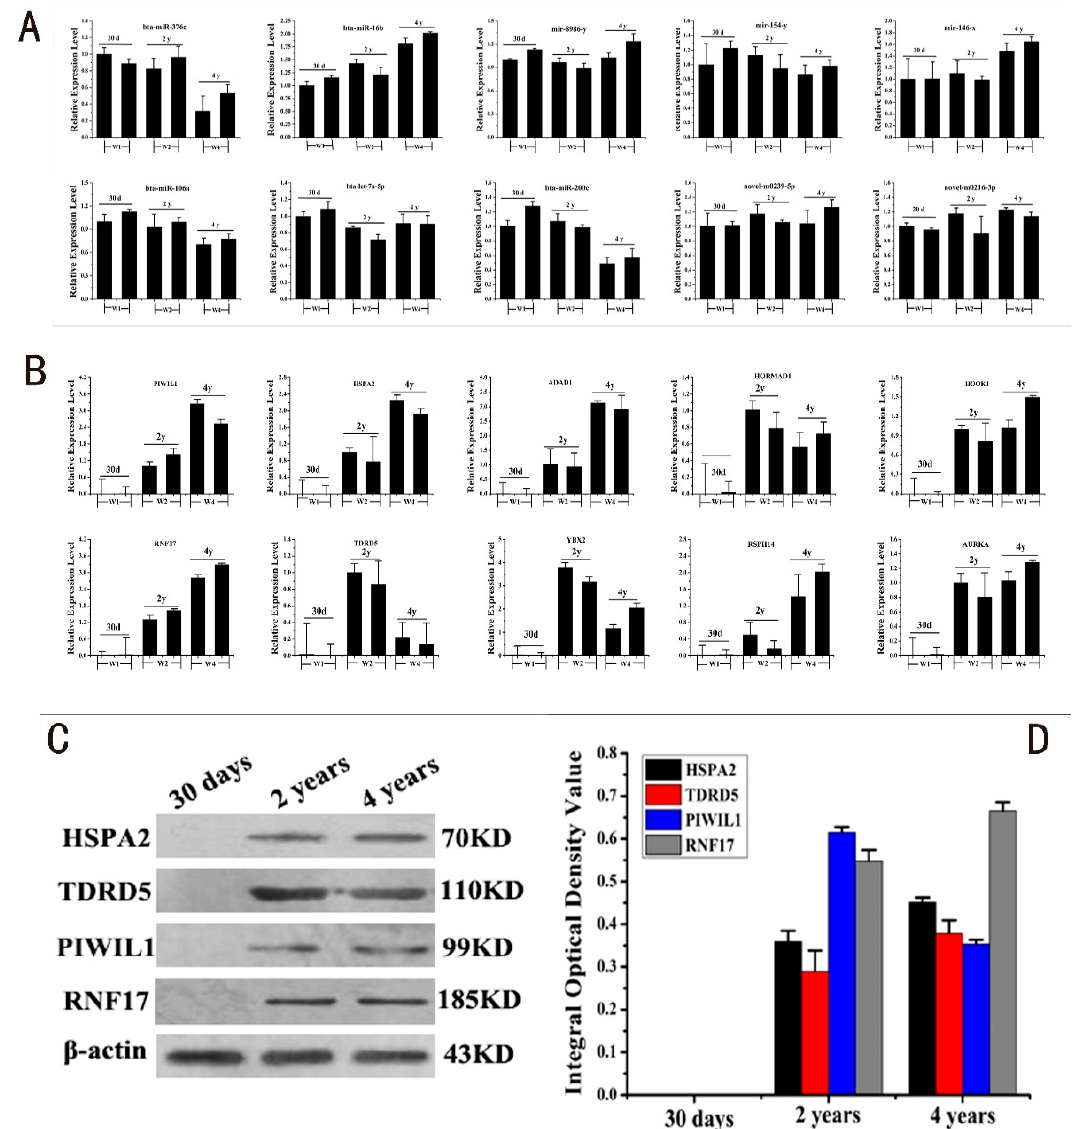
Figure 4. RT-PCR and Western blot assays for validating DERs and DEGs. ( A ) Stem-loop PCR assay for ten differentially co-expressed DERs. ( B ) Real-time PCR assay for ten differentially co-expressed DEGs. ( C ) Western blot assays for four highly co-expressed proteins in the three developmental stages. ( D ) The statistical graph for the four highly co-expressed proteins.